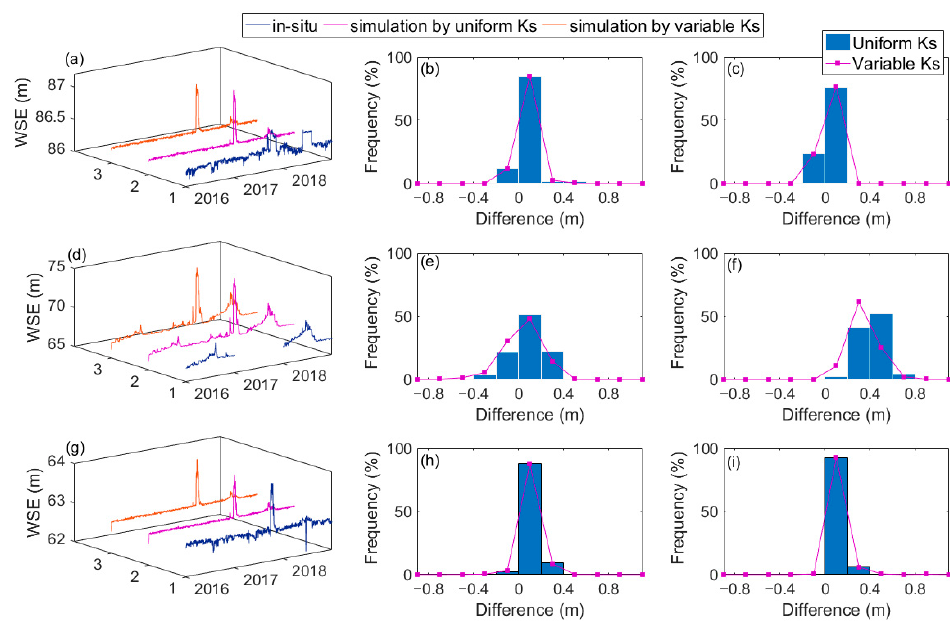
Figure 4. Validation of water surface elevation (WSE) obtained by configuration A against three in-situ gauging stations. Panel 1-3 indicate results at Laohekou, Miaogang, Xiangyang stations, respectively. ( a , d , g ) Comparisons of simulated and in-situ observations during the calibration and validation periods. ( b , e , h ) The distribution of di ff erences between simulated and in-situ observed WSE during the calibration periods. ( c , f , i ) The distribution of di ff erences between simulated and in-situ observed WSE during the validation periods.